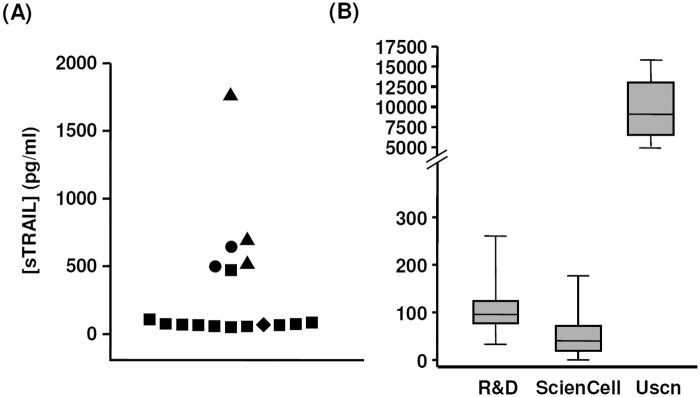
The reported values of the sTRAIL concentration in human blood in literature were highly variable, which might be related to the different assay kits used.(A) Dot plot showing the distribution of the mean sTRAIL concentrations (in pg/ml) in healthy controls reported in 17 published articles. ELISA assay kits from different suppliers were indicated by different symbol shapes. (B) Results obtained in the present study from the same set of 16 samples using ELISA kits from three different suppliers.